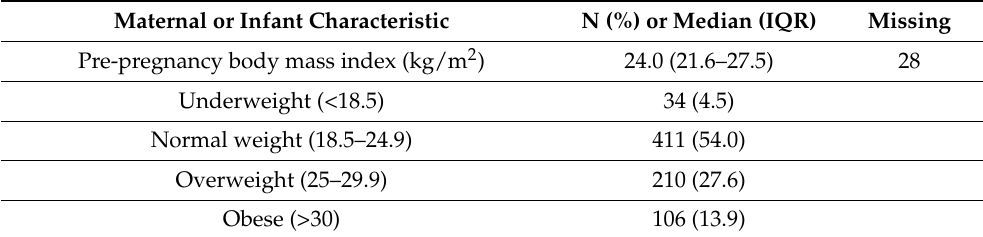
Table 2. Characteristics of study population ( n =